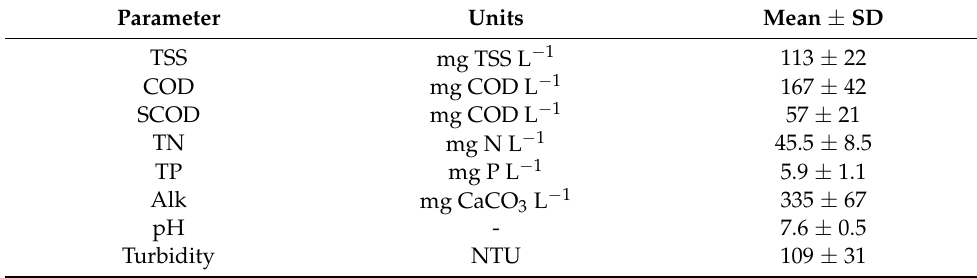
Table 1. Influent